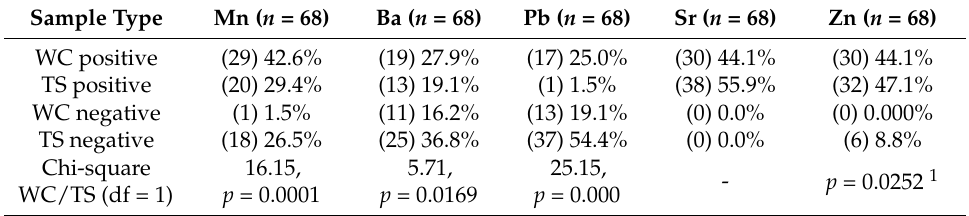
Table 3. Contingency table with the frequencies of selected five elements and associations of its occurrences between positive and negative bone samples from the Tian-Shan mountains (TS) and the Tatra mountains